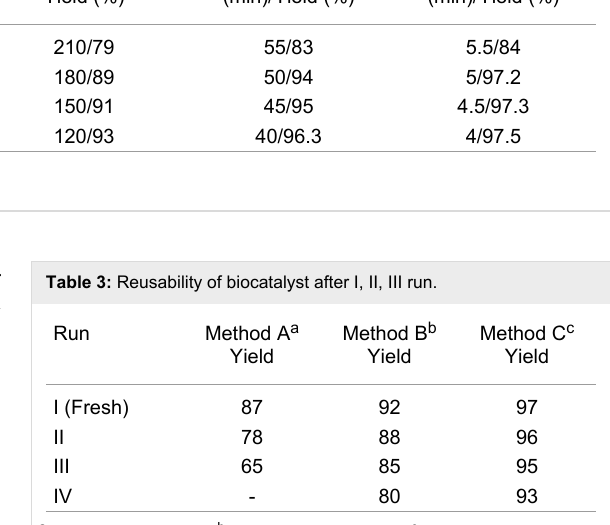
Table 2: Comparison of yields and time for the synthesis of hydroxy-substituted aliphatic amide using fatty acid ethyl ester R 1 = C 2 H 5 . Entry